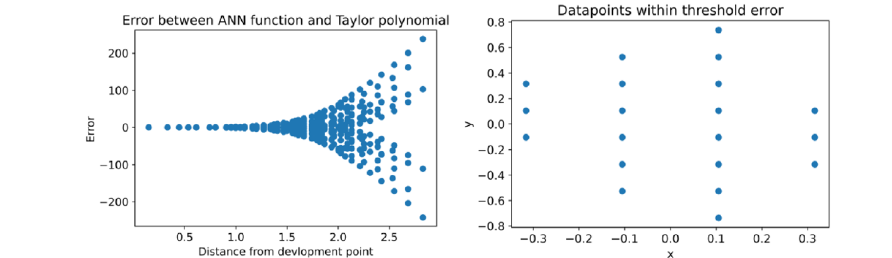
Fig. 8 Behaviour of error in 2 variable input